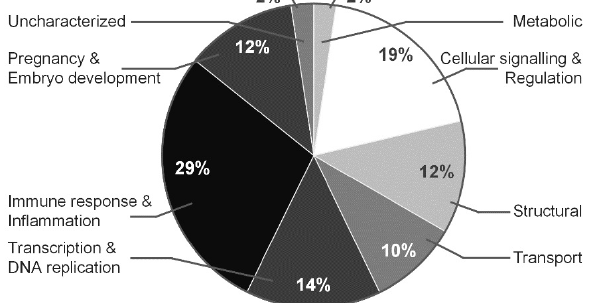
Figure 3. Functions of proteins identified in normal vs. polyhydramnios pregnancies, proteins fractionated in the pI 3–11 range. Proteins were clustered according to their functions by using AgBase [2.00 v].